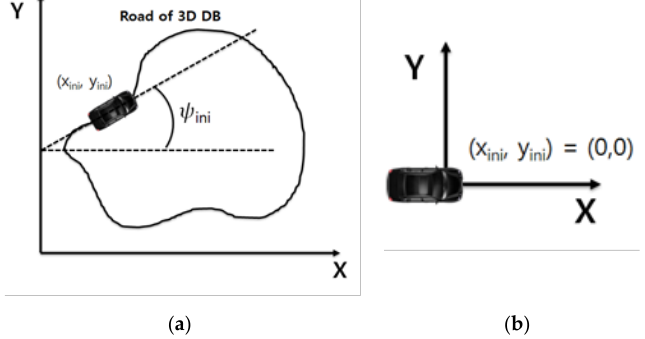
Figure 10. Coordinate systems of ( a ) the KAAS and ( b ) CARSIM (TRUCKSIM).